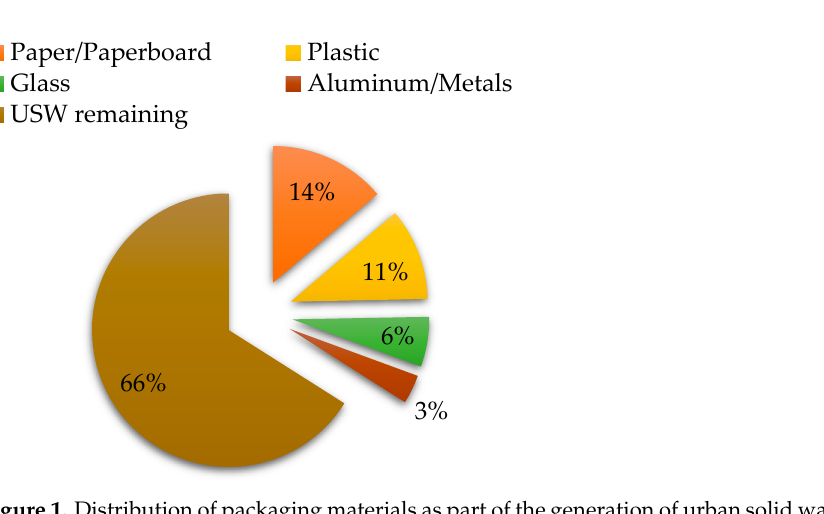
Figure 1. Distribution of packaging materials as part of the generation of urban solid waste (USW) [4].